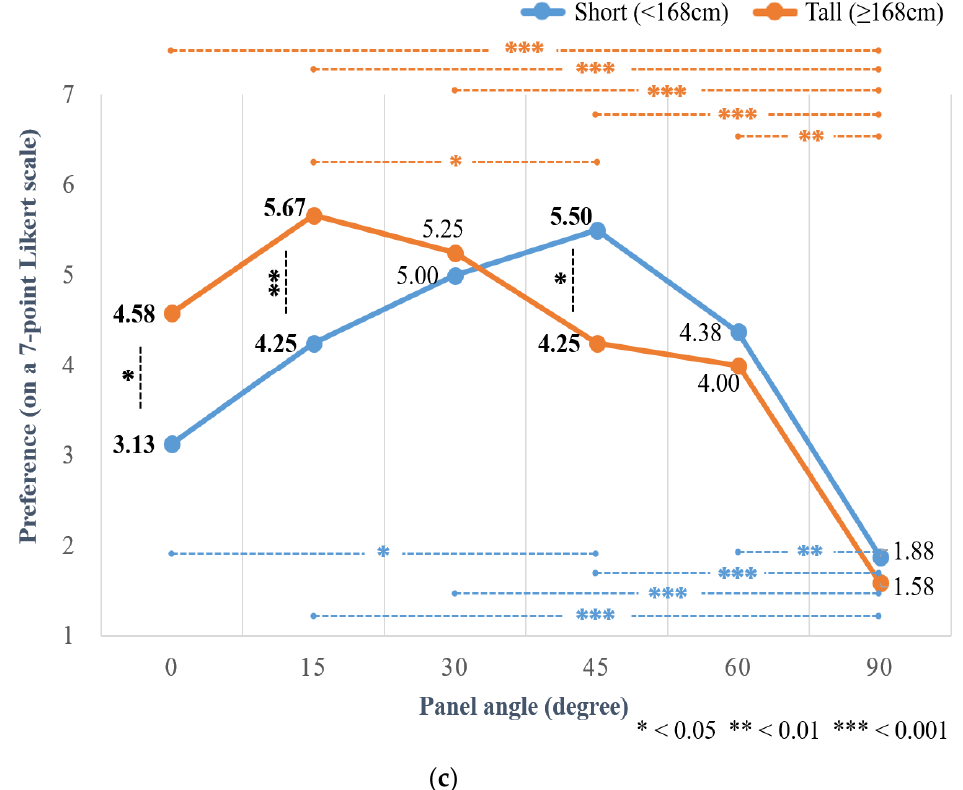
Figure 6. Interaction effects between panel angle and participant height on ( a ) visibility, ( b ) physical comfort, and ( c ) preference. The blue and orange asterisks indicate significant angle effects for the “short” and “tall” groups, respectively, and the black asterisks indicate significant height effects for each panel angle.